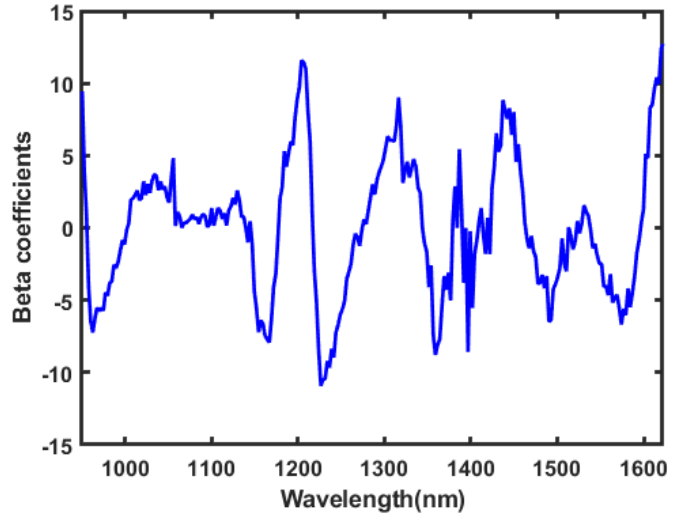
Figure 8. The obtained beta coefficient based on the raw preprocessing.